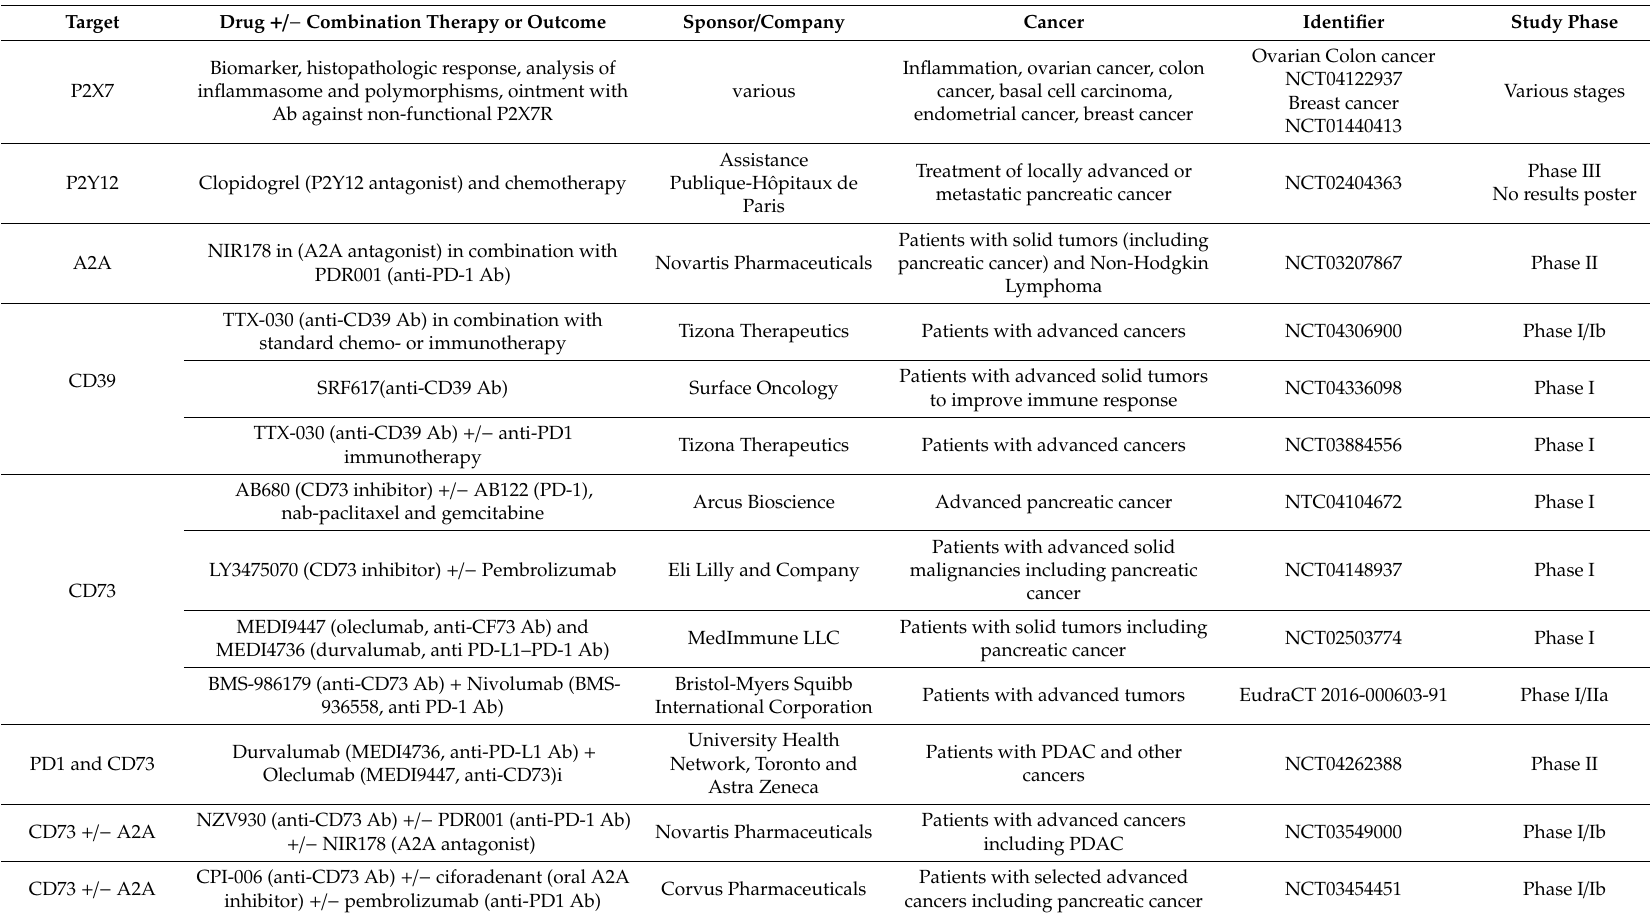
Table 1. Clinical trials (from NIH and EU registers) testing the potential use of purinergic targets in pancreatic and other cancers. Purpose of the studies varies from feasibility to safety, tolerability, pharmacokinetics, immunogenicity, and anti-tumor